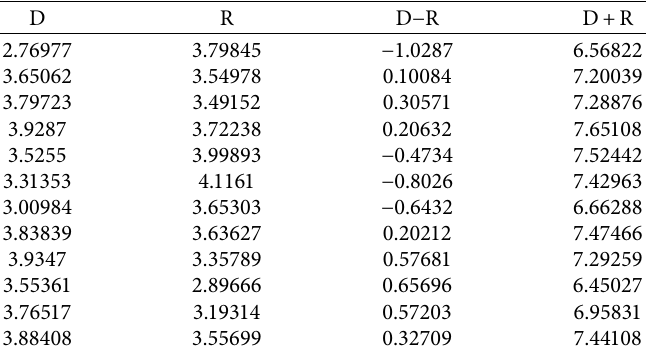
Table 10: Classification of potential PMO